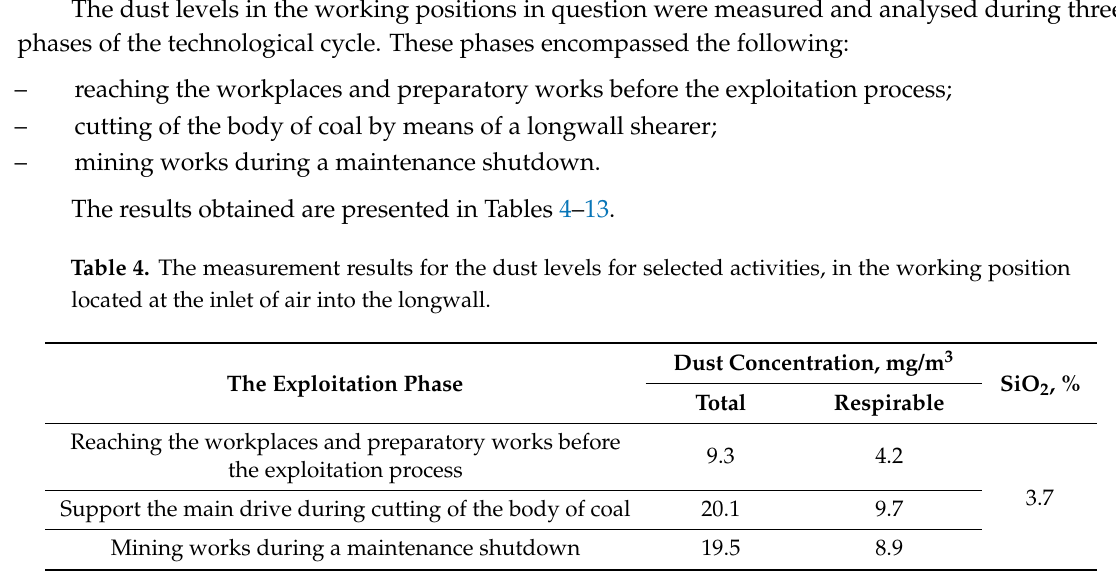
Table 5. The measurement results for the dust levels for selected activities, in the working position miner operating the scraper conveyor.